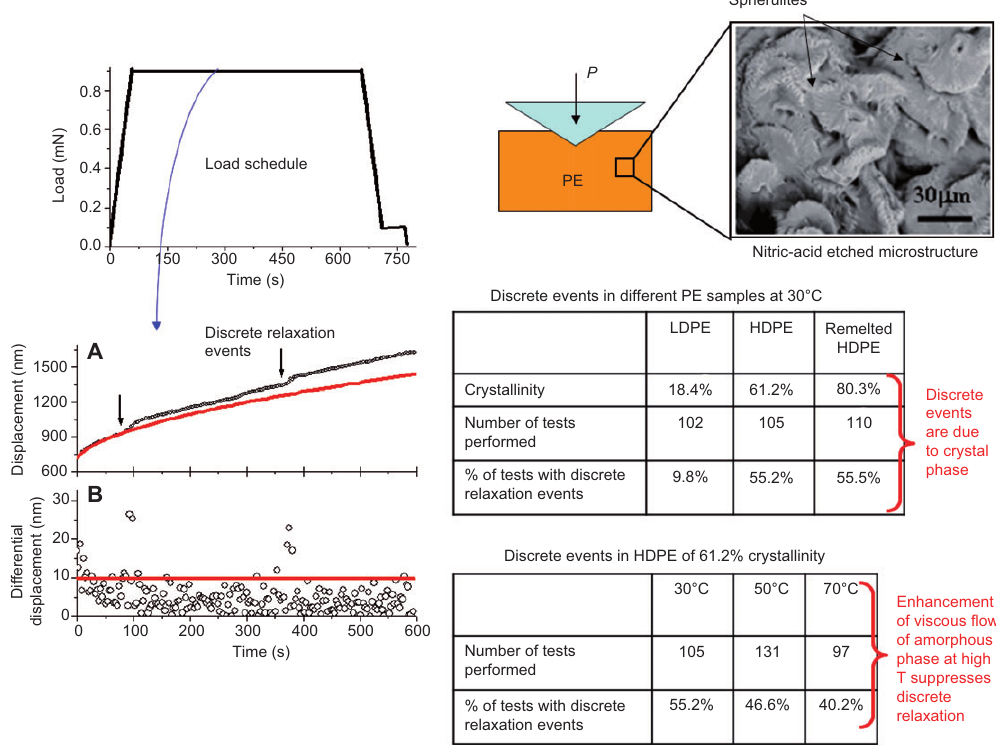
Figure 4 Discrete plastic events in PE during nanoindentation creep tests. Data from ref. [8] .